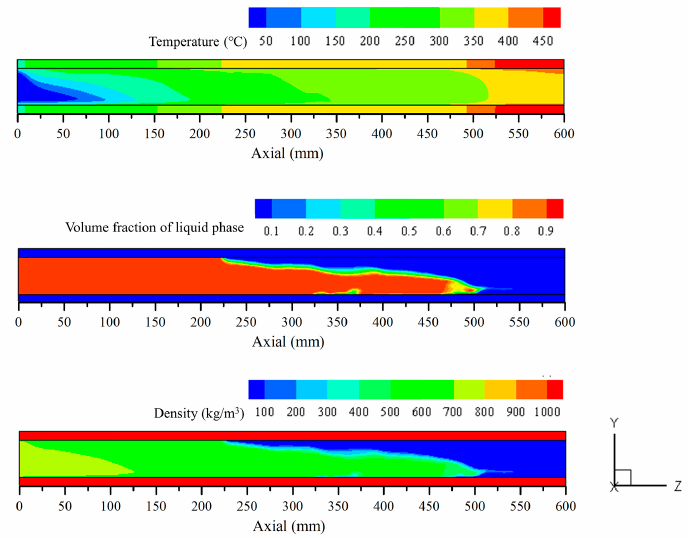
Figure 6. Distribution of the flow field under a subcritical pressure of 1.5 MPa (numerical results of Case 1, X = 0 mm).